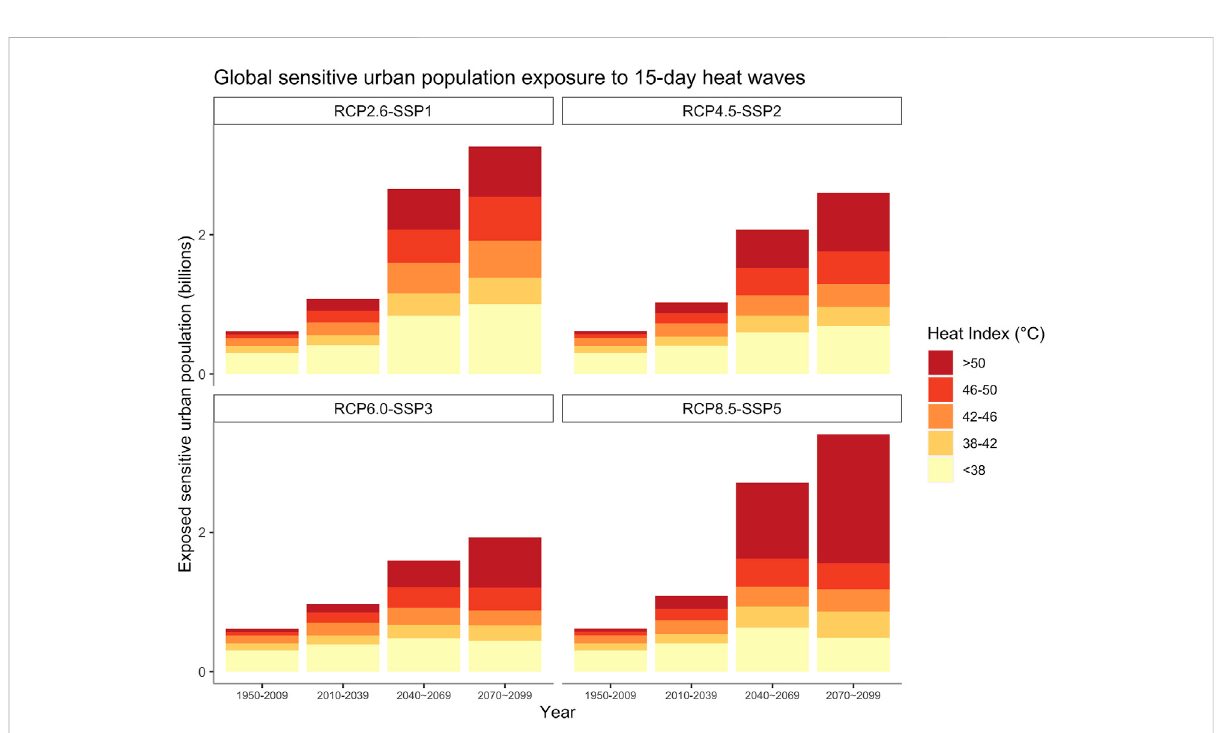
FIGURE 7 Global sensitive urban population exposure to extreme heatwaves. This chart presents the mean global urban sensitive population ( < 5 and > 64 years of age) projected to be exposed to 15-day heatwaves of > 42 ° C by RCP-SSP pairs.